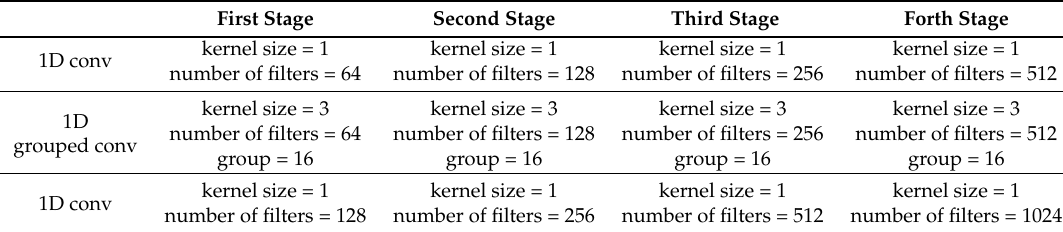
Table 1. Detail parameters of bottleneck